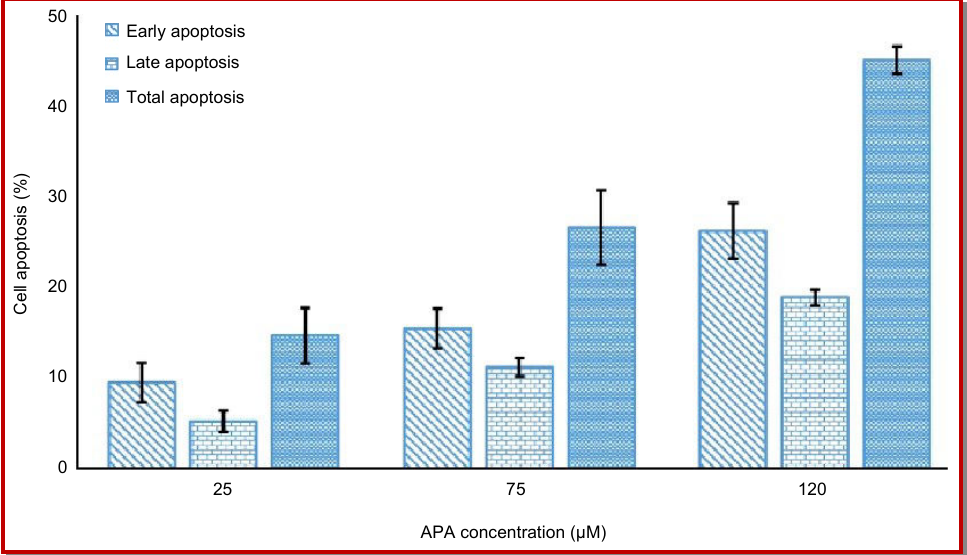
Figure 5: Percentages of cells in early and late apoptosis at each APA concentration. Results are presented as the mean of three similar experiments ± standard deviation